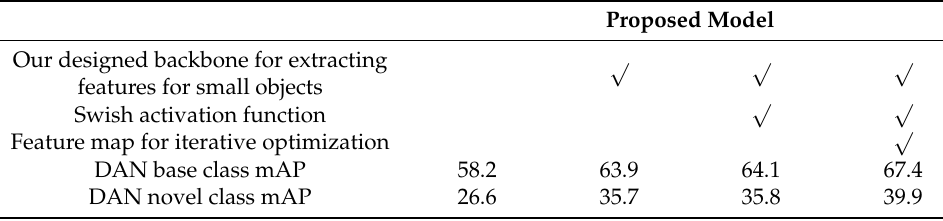
Table 3. Effectiveness of different components on DAN base classes and DAN novel classes. Input image size is 640 × 640 and predictions are measured on the mAP at 0.5 IoU metric. Experiments start with a basic SSD model. Our complete proposed model achieves mAP 67.4 and 39.9 when tested on DAN base classes and DAN novel classes, respectively, and “ are